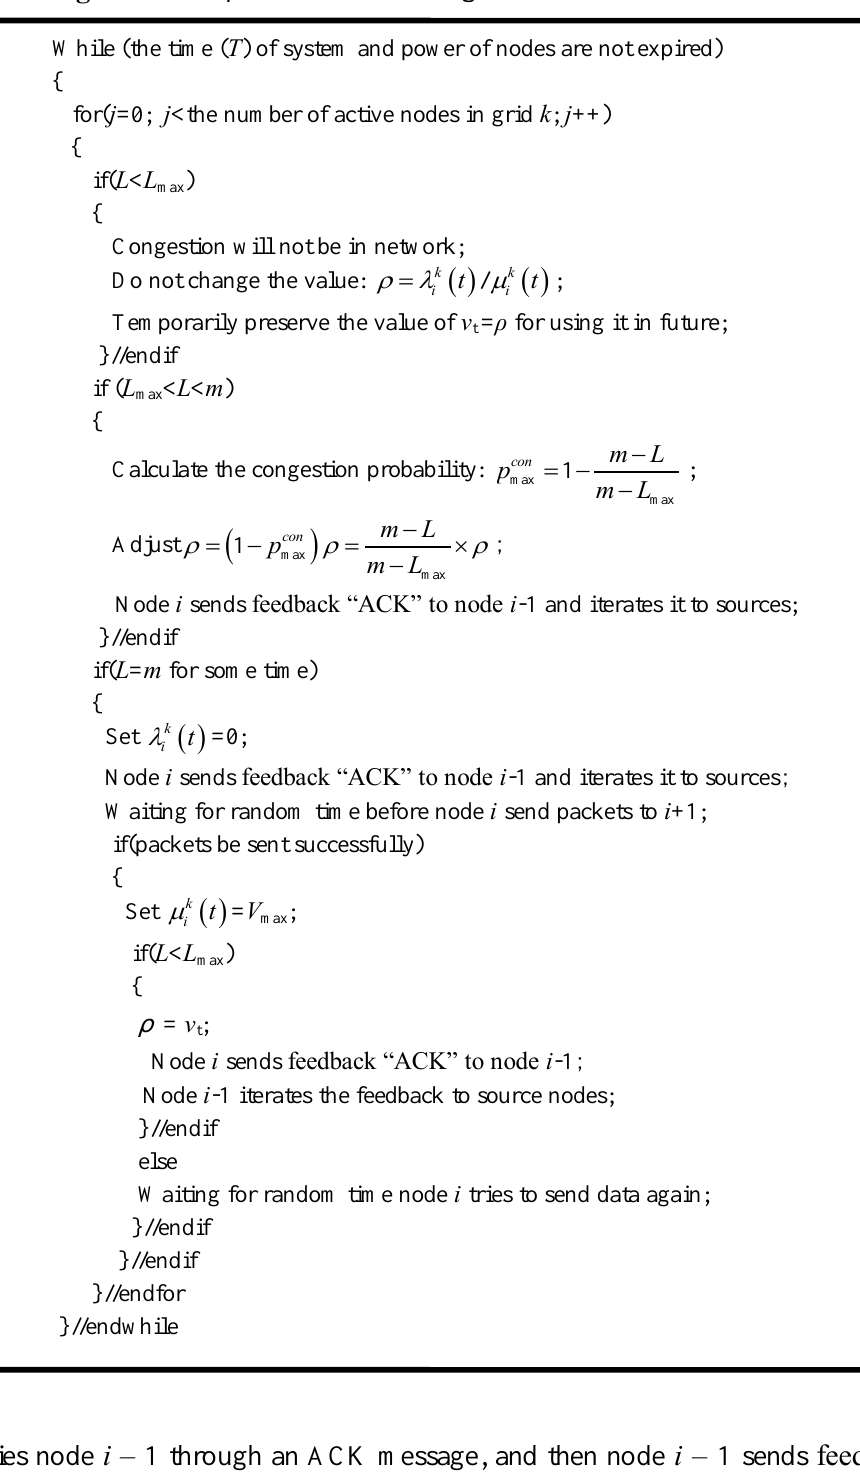
Figure 5. The pseudo-code for single-node rate control